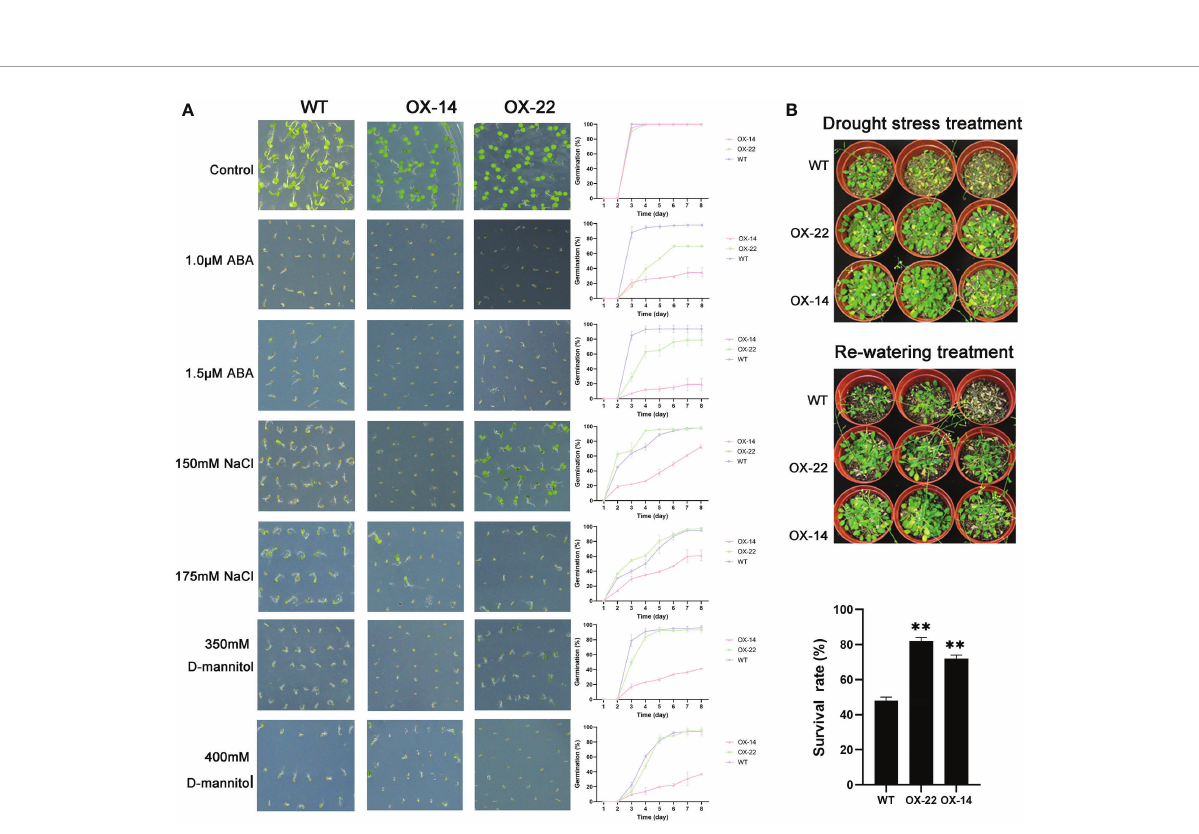
FIGURE 7 Germination and phenotype analysis ZmNAC4 overexpressing Arabidopsis. (A) Germination assays of ZmNAC4 were performed under the presence of 1.0 m M and 1.5 m M ABA, 150 mM and 175 mM NaCl, 350 mM and 400 mM D-mannitol. Each measurement consists of 50 seeds. (B) Performance and survival rate of the ZmNAC4 overexpressing lines under drought stress and re-watering treatments. Three biological replicates and calculate the average. Highly signi fi cant differences (P < 0.01) were represented by